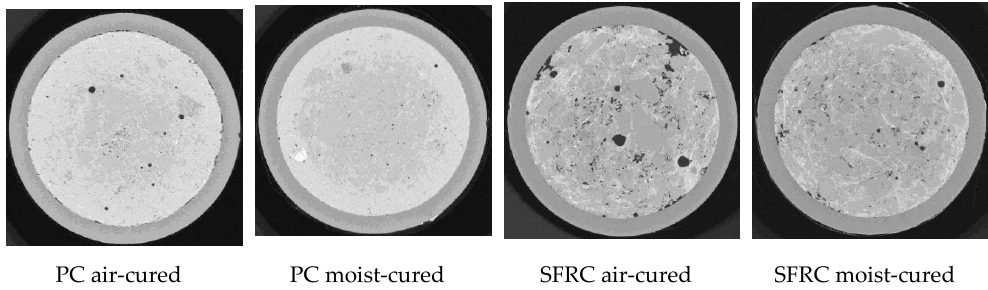
Figure 2. Slices belonging to different mixtures and curing conditions.